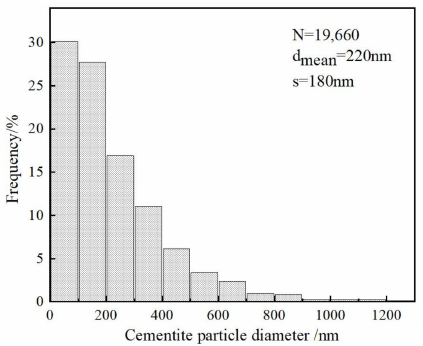
Figure 6. Distribution of cementite particles at 75% strain.